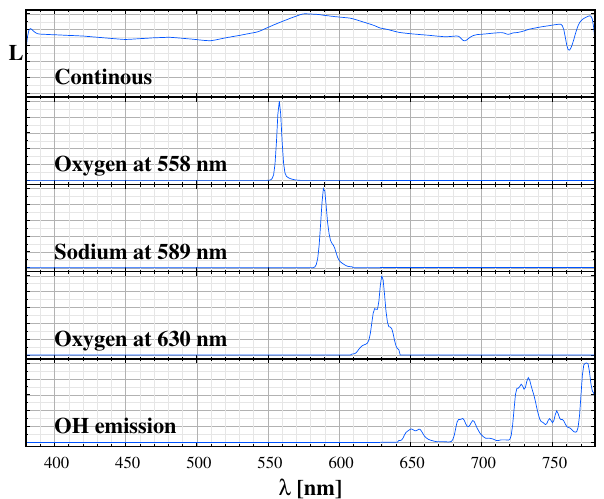
Figure 1. Components of the natural sky spectrum used to fit the observations. From top to bottom: continuous component, 558 nm (green) oxygen emission, 589nm sodium emission, 630nm (red) oxygen emission, OH